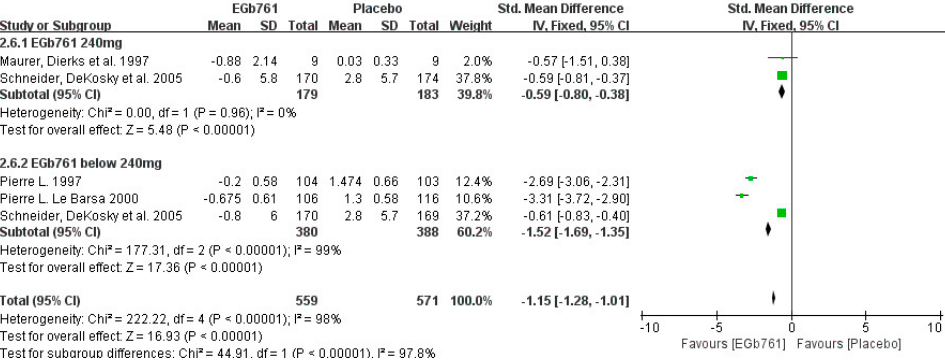
Figure 8. Forest plot of comparison: meta-analysis of ADAS-Cog scores in AD patients taking placebos or GBE, at doses of 240 mg/d, and below 240 mg/d. The square area represents the weight assigned to the study in the meta-analysis. The horizontal line represents the 95% confidence